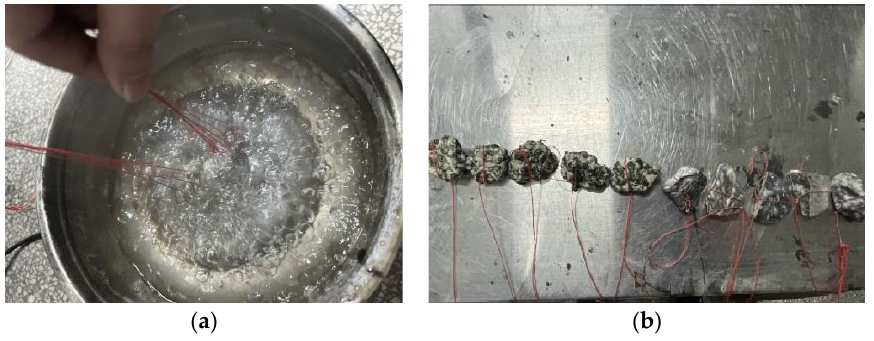
Figure 3. Polyurethane binder and aggregate adhesion test. ( a ) In boiling; ( b ) after